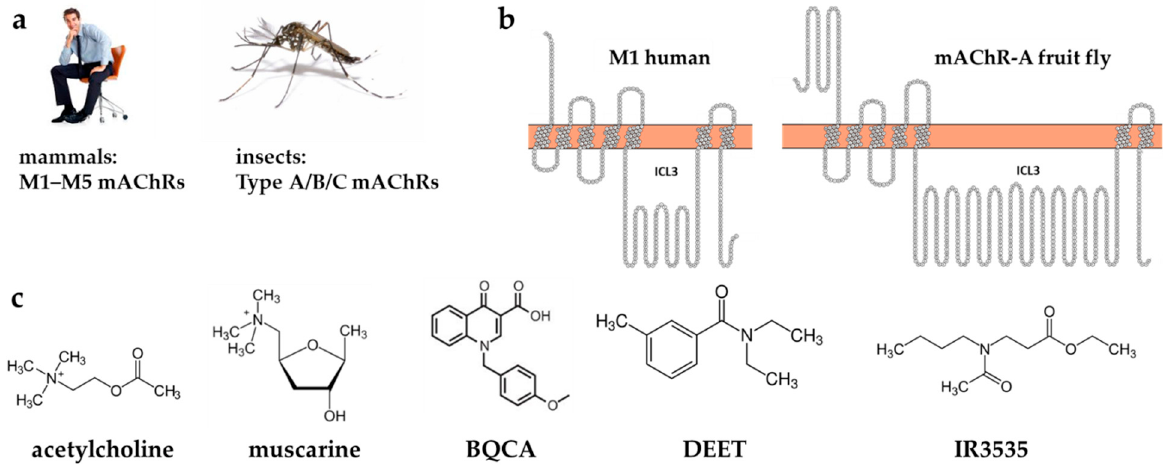
Figure 1. ( a ) Muscarinic acetylcholine receptors (mAChR) are divided into M1–M5 subtypes in mammals and A/B/C types in insects. ( b ) Snake plots [29] of human M1 (left) and fruit fly ( Drosophila melanogaster ) mAChR-A show the main structural features of a GPCR receptor—seven transmembrane helices linked by three extracellular and three intracellular loops among which the third one (ICL3) is the largest. Note that ICL3 is neither present in the human X-ray structure used in this study nor in the fruit fly homology model. ( c ) Structures of classical M1 agonists—acetylcholine, atropine; BQCA modulator and DEET and IR3535